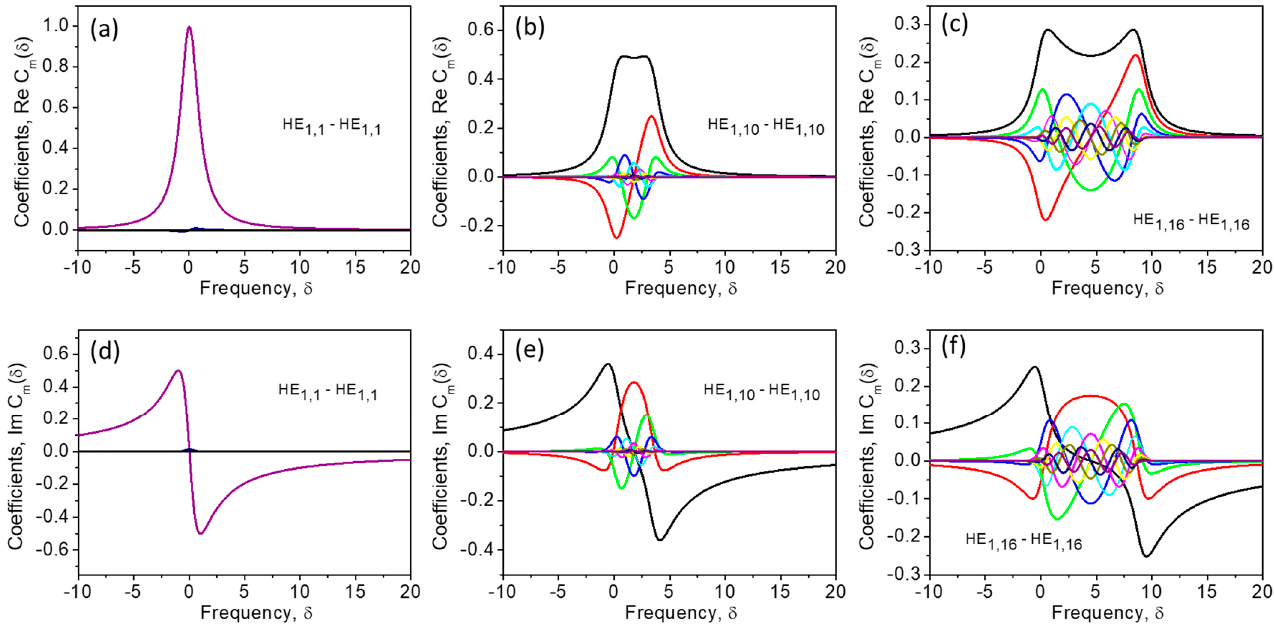
Figure 6. The coefficients C m ( δ ) ( m = 1,2...10) as functions of the frequency δ for interaction of the modes of different orders ( a – f ) in an optical fiber; the real ( a – c ) and imaginary ( d – f ) parts. Calculations are performed using Equation (23).